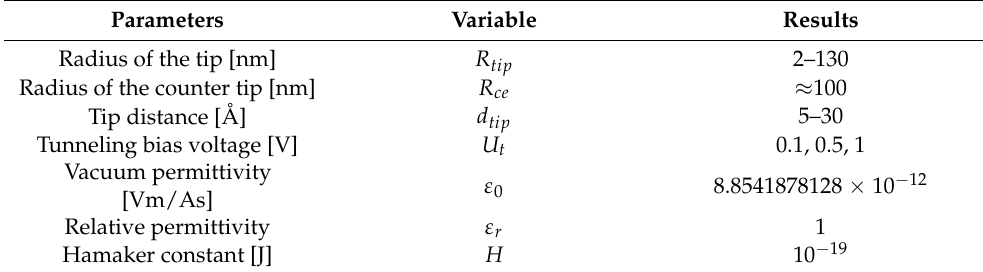
Table 2. Parameters of the tunneling tips for calculation of attractive forces.